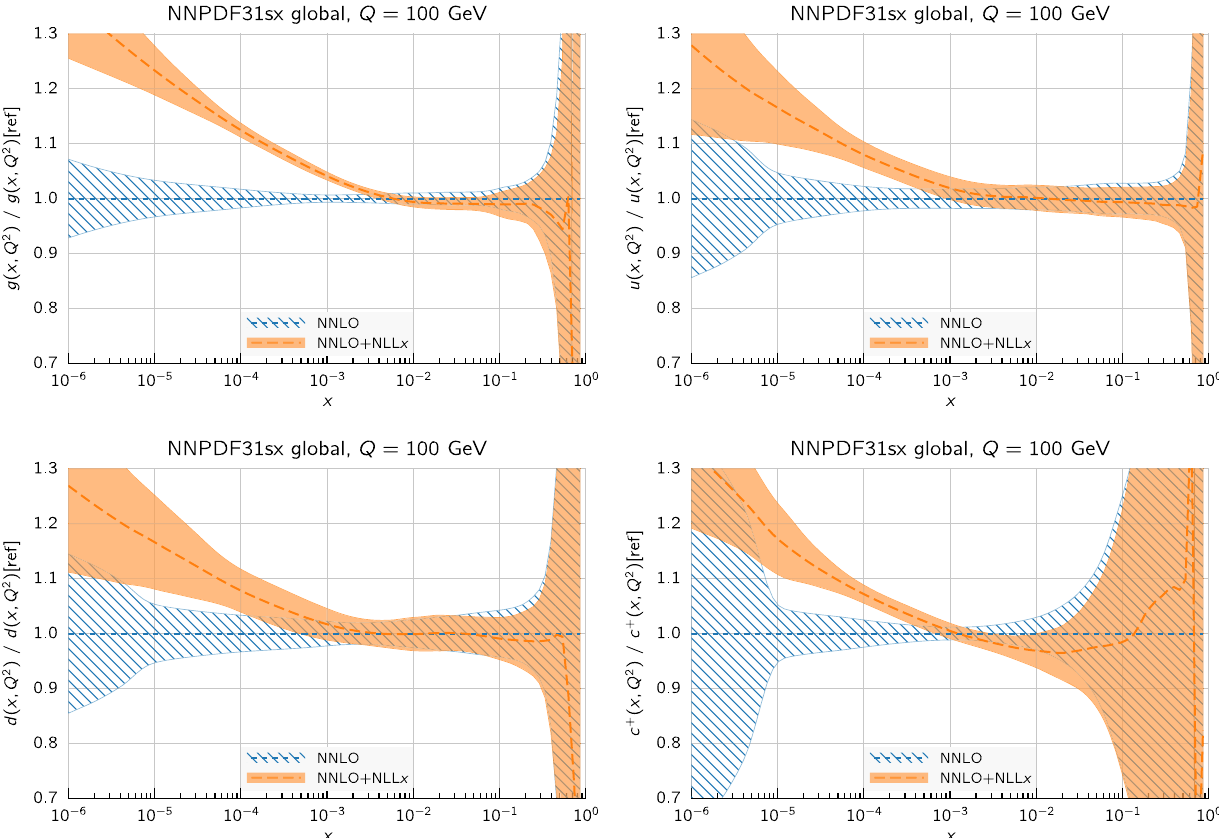
Fig. 15 Comparison of the NNPDF3.1sx NNLO and NNLO+NLL x global fits at Q = 100 GeV. We show the gluon PDF and the charm, up, and down quark PDFs, normalized to the central value of the baseline NNLO